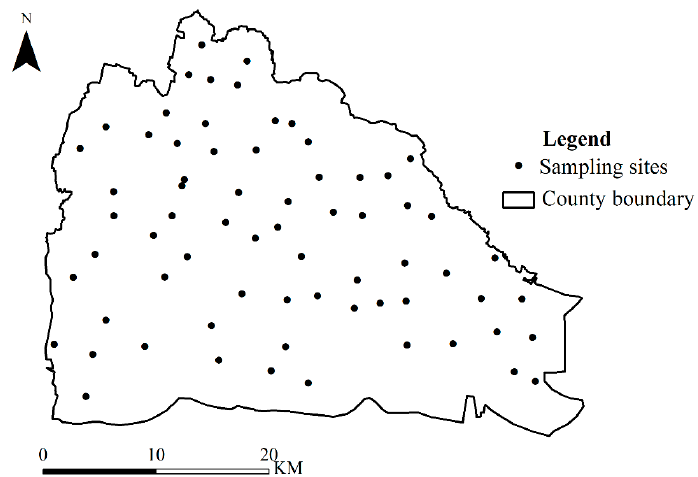
Figure 1. Distribution map of sampling sites in Fengqiu county.